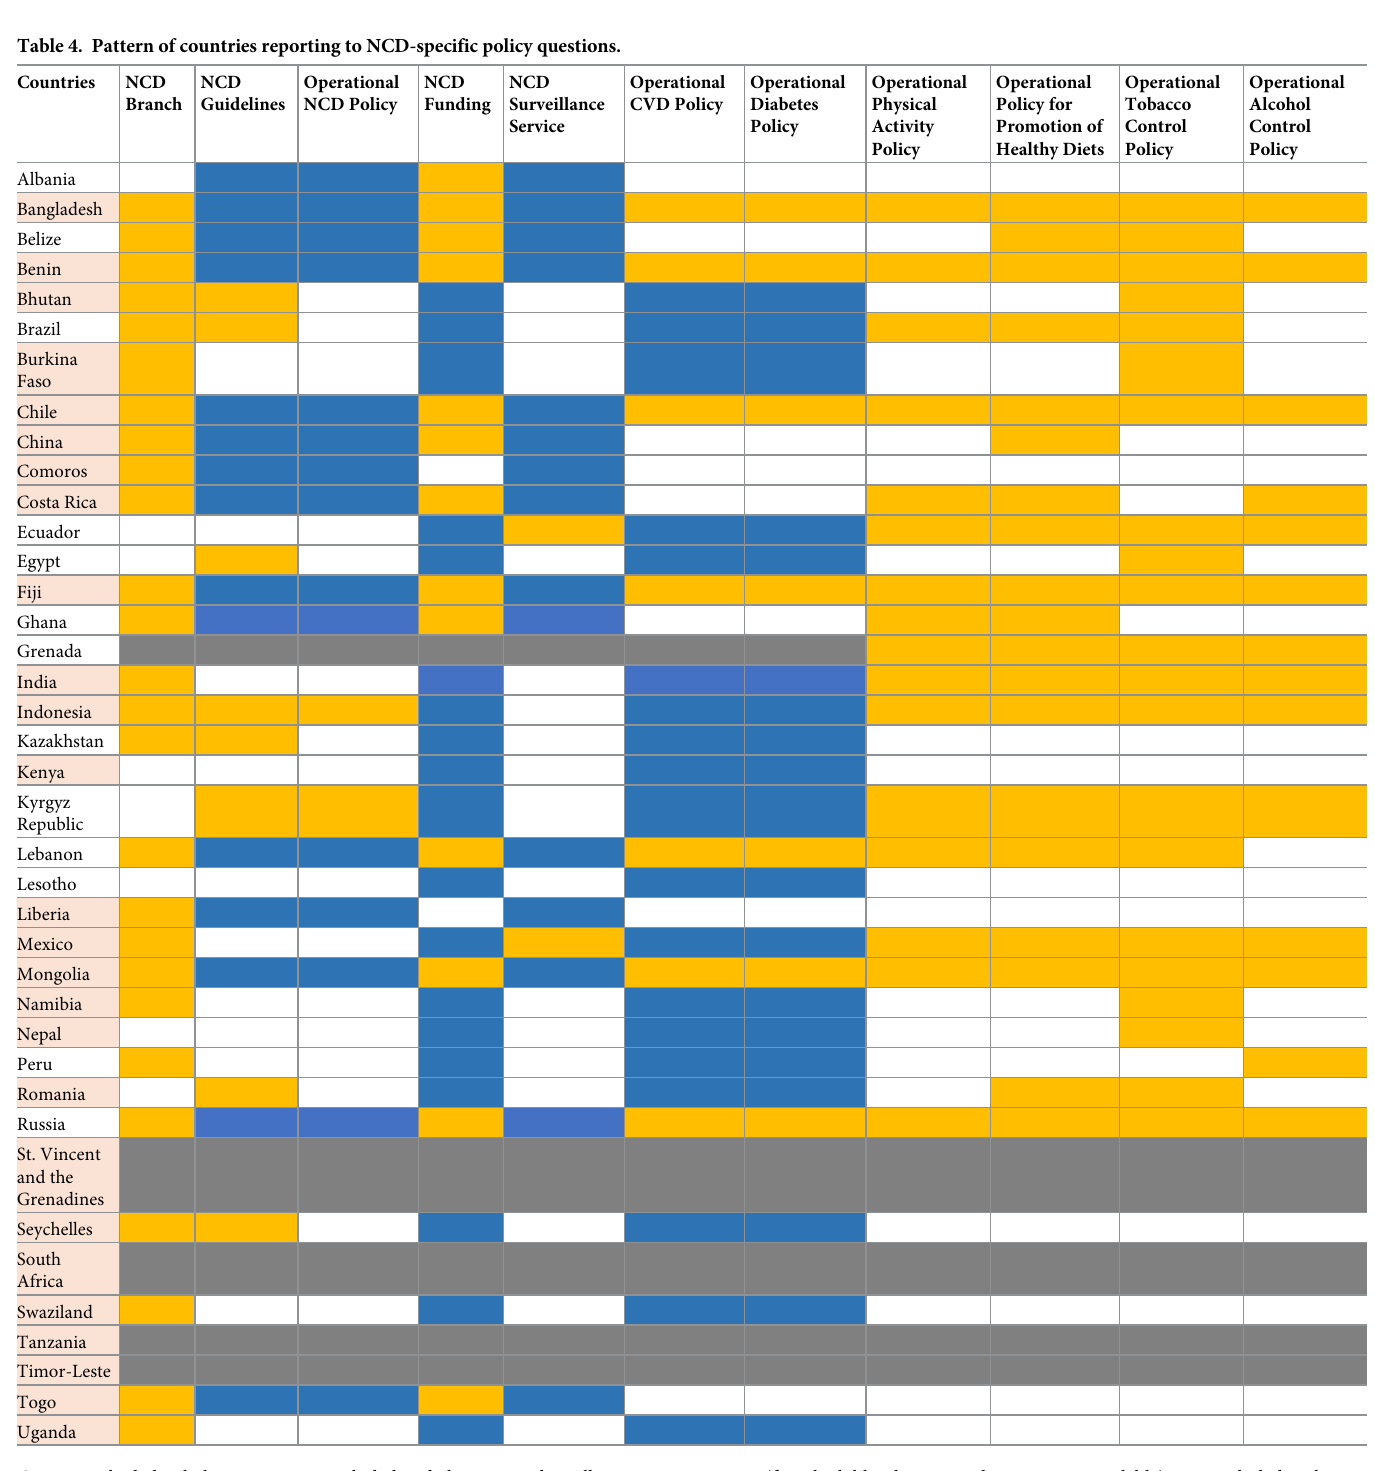
Countries shaded in light orange were included in diabetes cascades. All countries except Fiji (for which blood pressure data were not available) were included in the hypertension cascades. Responses to questions are shaded as follows: white, ‘no’; orange, ‘yes’; grey, ‘no response to survey’; blue, ‘responded to survey, but question not asked in survey’. N = 5 countries (Azerbaijan, Georgia, Guyana, Mozambique, and Ukraine) were missing data and are not listed in table. Abbreviations: CVD, cardiovascular disease; NCD, noncommunicable